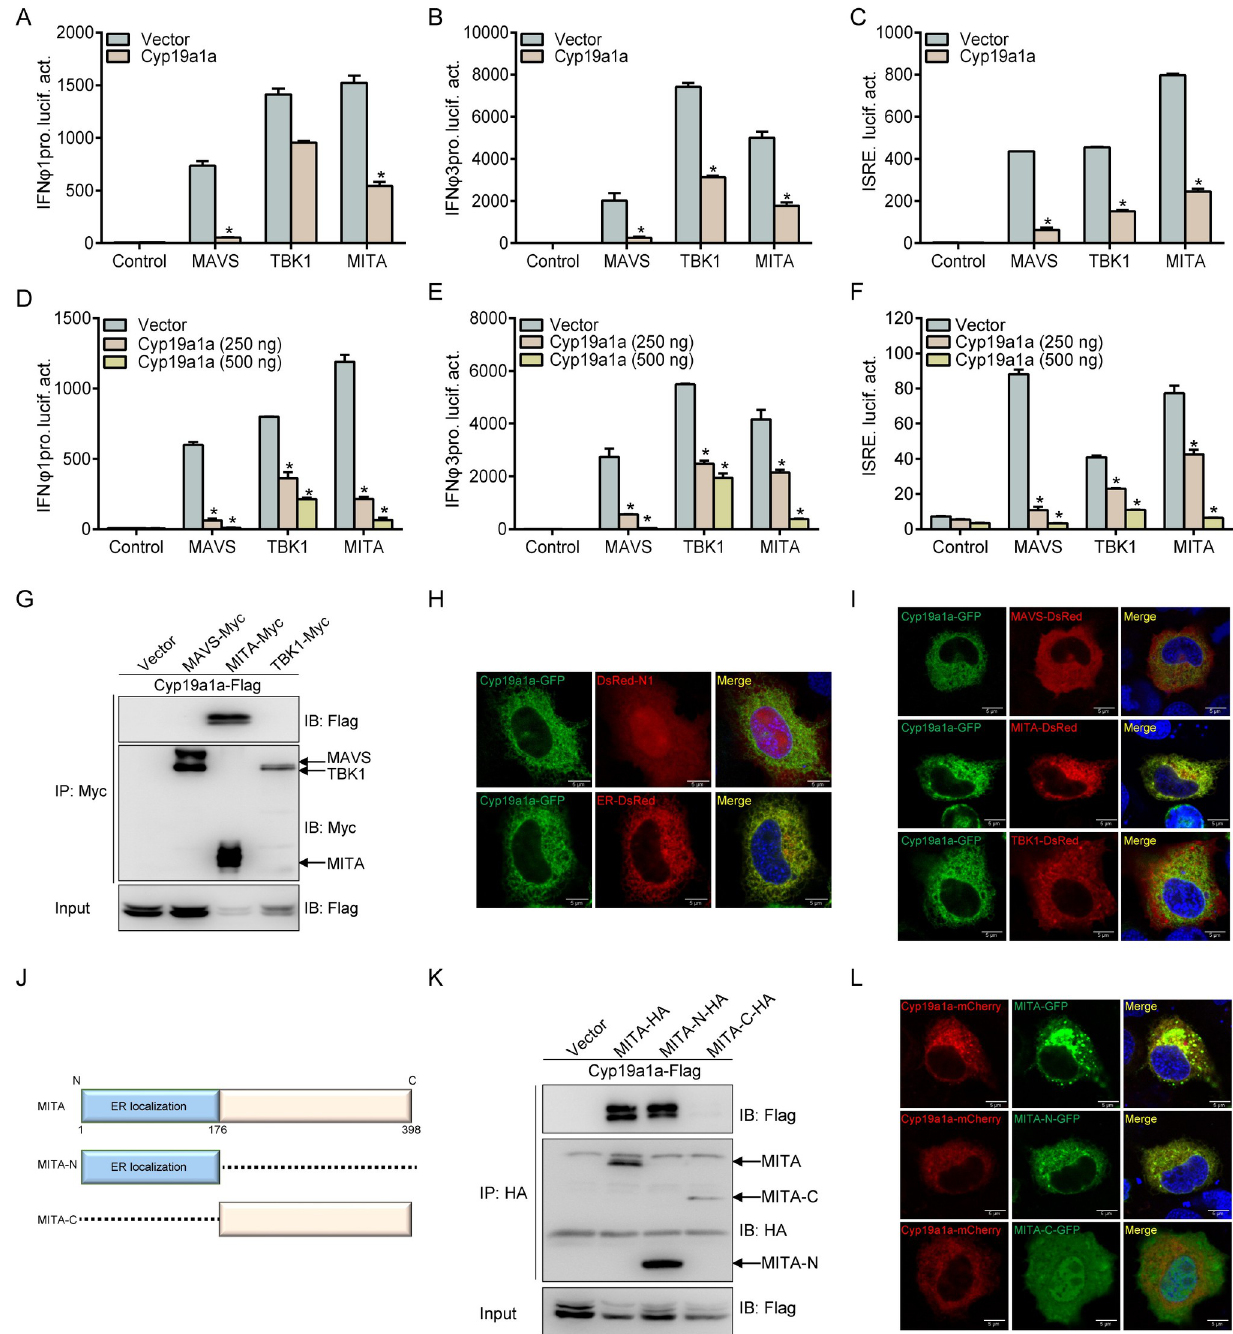
Fig 4. Cyp19a1a interacts with and blocks MITA-mediated IFN activation. (A-F) Co-transfected with MAVS-, TBK1-, MITA-expressing plasmid and empty vector or Cyp19a1a-Flag (250 ng or 250/500 ng), plus IFN φ 1pro-Luc (A and D) or IFN φ 3pro-Luc (B and E) or ISRE-Luc (C and F) at the ratio of 1:1:1, pRL-TK was used as a control. At 24 h post-transfection, cells were lysed for luciferase activity detection. Data were expressed as mean ± SEM, n = 3. Asterisks indicate significant differences from control ( � , p < 0.05). (G) EPC cells were transfected with the indicated plasmids (5 μ g each). After 24 h, cell lysates were immunoprecipitated (IP) with anti-Myc affinity gel. Then the immunoprecipitates and WCLs were analyzed by IB with the anti-Myc and anti- Flag Abs, respectively. (H and I) EPC cells were co-transfected with 1 μ g Cyp19a1a-GFP plus 1 μ g empty vector, ER-DsRed (H) and MAVS-DsRed/ TBK1-DsRed/MITA-DsRed (I). After 24 h, the cells were fixed and subjected to confocal microscopy analysis. Green signals represent overexpressed Cyp19a1a, red signals represent overexpressed ER or RLRs. The yellow staining in the merged image indicates the colocalization of Cyp19a1a and ER or MITA (original magnification 63 × ; oil immersion objective). Scale bar, 10 μ m. (J) Schematic representation of full-length MITA and two mutants (MITA-N containing the ER localization domain and MITA-C containing the C-terminal 222 amino acids). (K) EPC cells were co-transfected with the